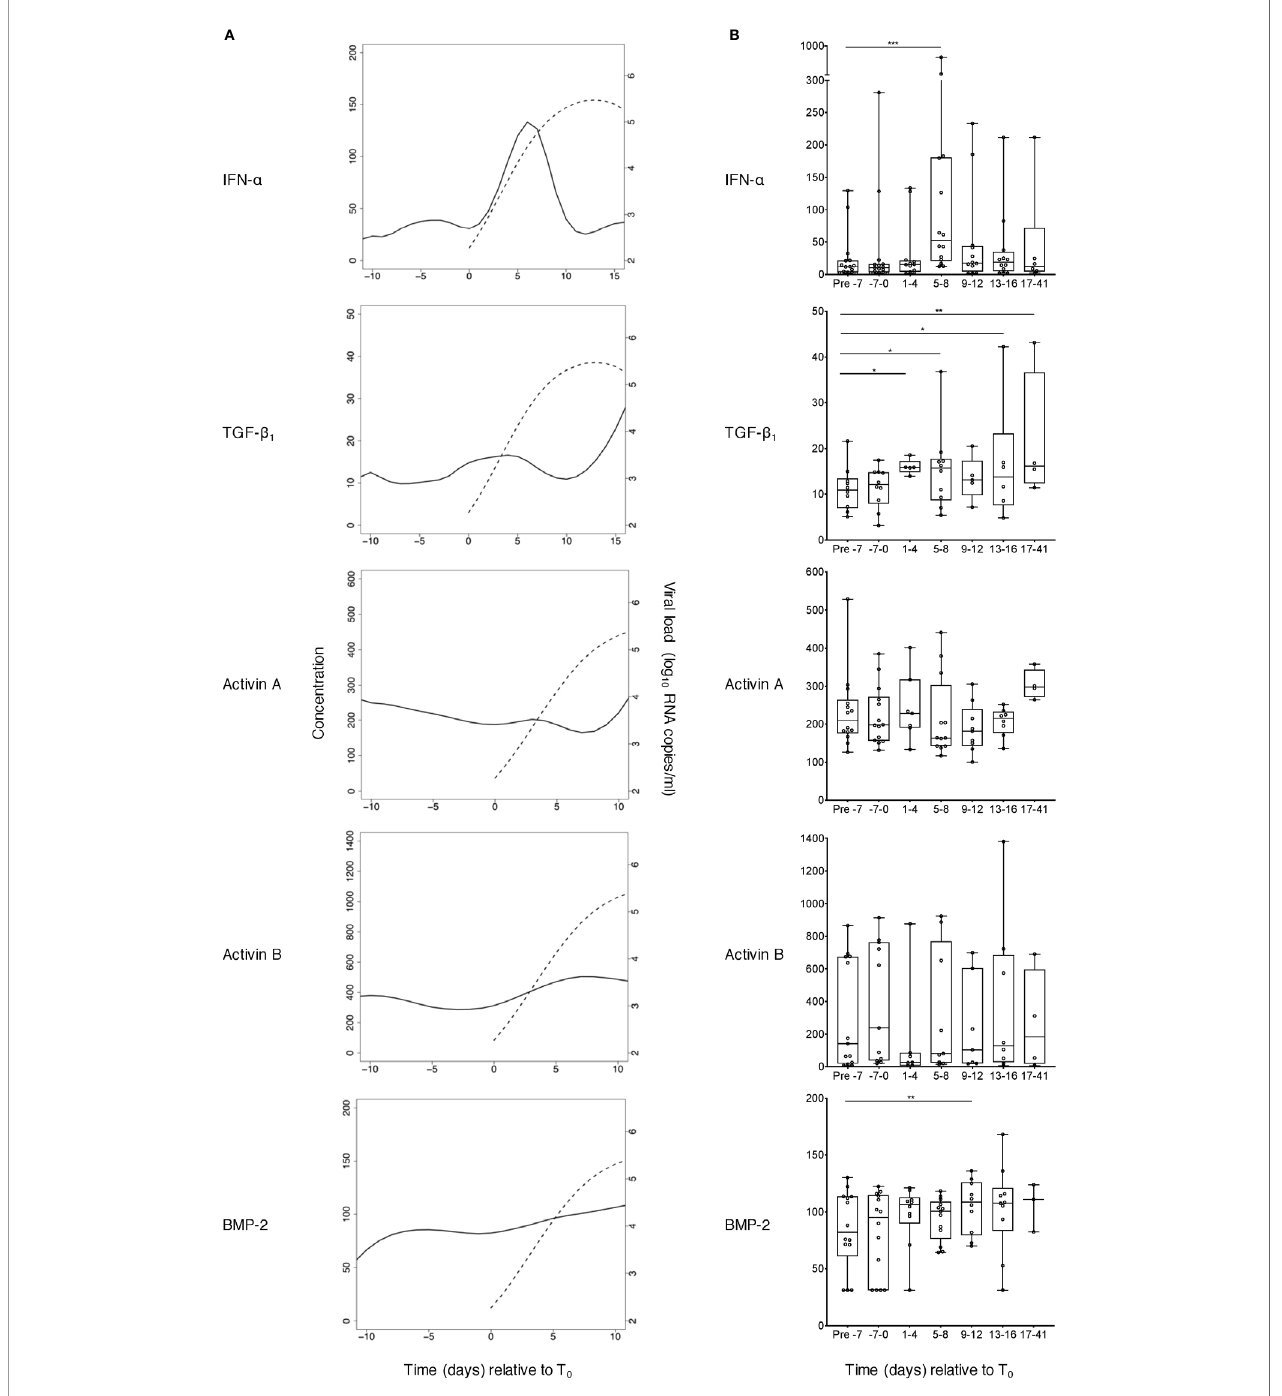
FIGURE 2 | Perturbations in plasma concentrations of IFN- a and TGF- b superfamily cytokines during acute HIV-1 infection. (A) TGF- b 1 , activin A, activin B and BMP-2 concentrations were measured in plasma samples collected at time-points both pre- and post-T 0 (the time-point when viral load fi rst reached detectable levels (100 RNA copies/ml)) from plasma donors who became acutely infected with HIV-1 during the time-frame of serial plasma donation. IFN- a levels in the same samples had already been evaluated as part of a prior study (5). Data from n=15 (IFN- a ), n=10 (TGF- b 1 ), n=14 (activin A), n=13 (activin B), or n=14 (BMP-2) donor time-courses were combined and plotted using cubic interpolation splines. Solid lines represent cytokine concentrations (pg/ml, except TGF- b 1 which is in ng/ml), and dashed lines represent viral load (RNA copies/ml). (B) Pooled data were binned, and the pre- day − 7 (relative to T 0 ) bin was used as a baseline to which other bins were compared, using linear mixed-effects modelling (*P < 0.05, **P < 0.01, ***P < 0.001). Box plots represent the limits of the 25th and 75th percentile, with the central line showing the median. Whiskers represent the range. All cytokine concentrations are in pg/ml, except TGF- b 1 which is in